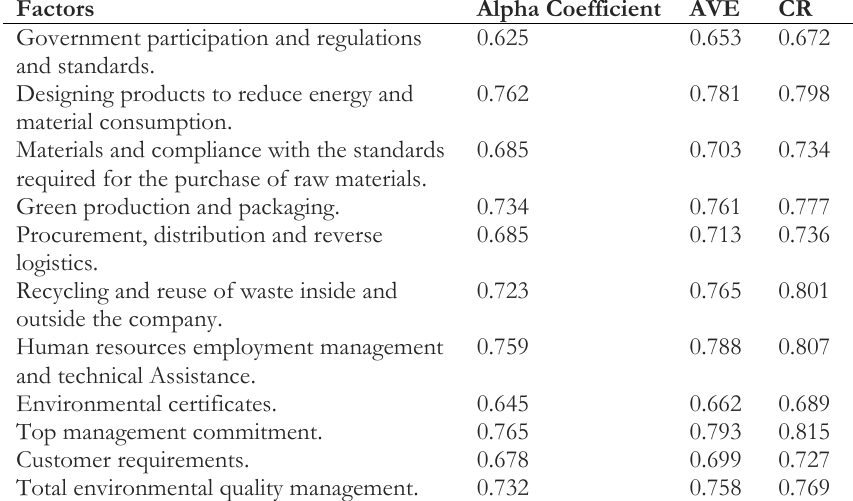
Table 4. The reliability and validity of the research